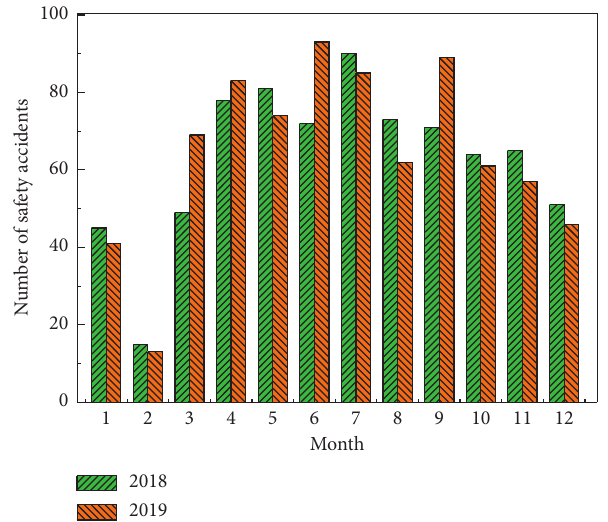
Figure 1: The number of production safety accidents in China’s housing and municipal engineering in 2019.